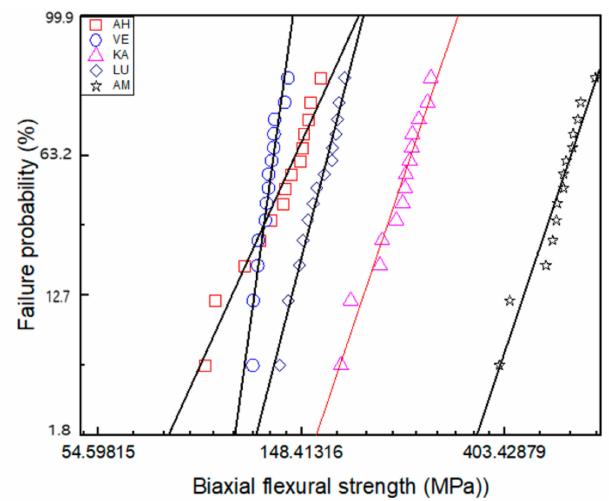
Figure 9. Failure probability according to the Weibull analysis of biaxial flexural